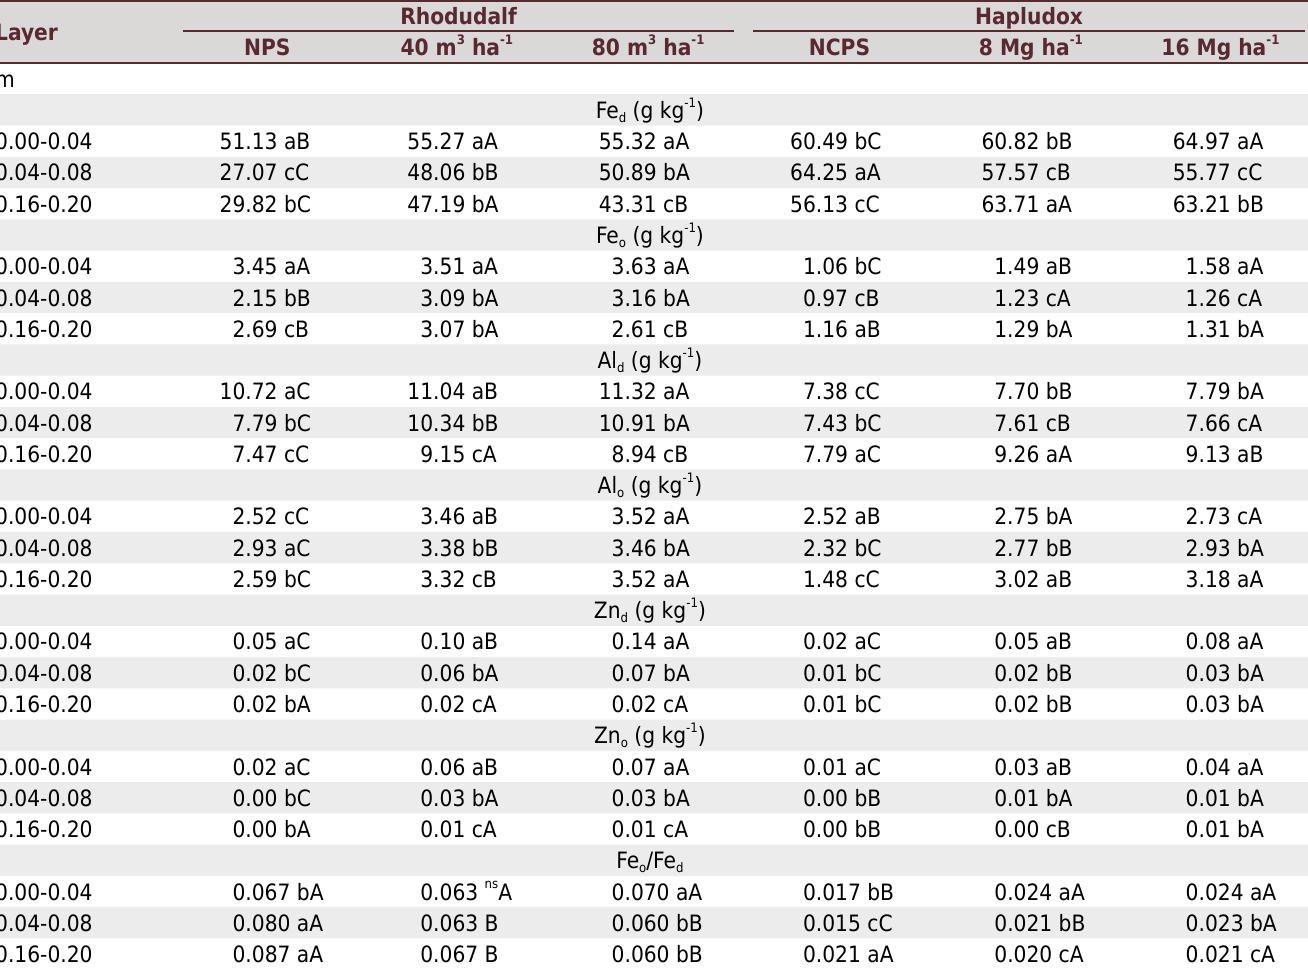
Table 2. Contents of Fe, Al, and Zn extracted by DCB (d) and acid ammonium oxalate (o) from the clay fraction of a Typic Rhodudalf and Typic Hapludox under long-term organic fertilization in no-tillage systems Rhodudalf Hapludox Layer NPS 40 m 3 ha